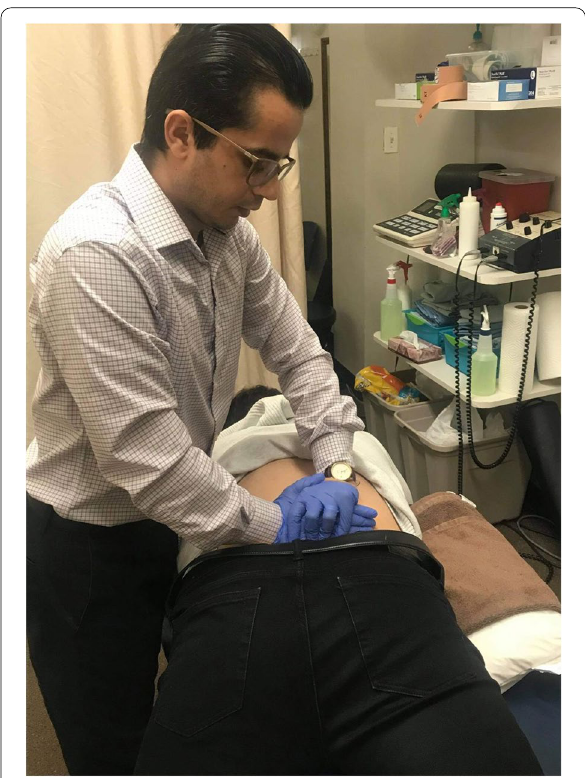
Fig. 3 Application of grade-4 Maitland mobilization technique